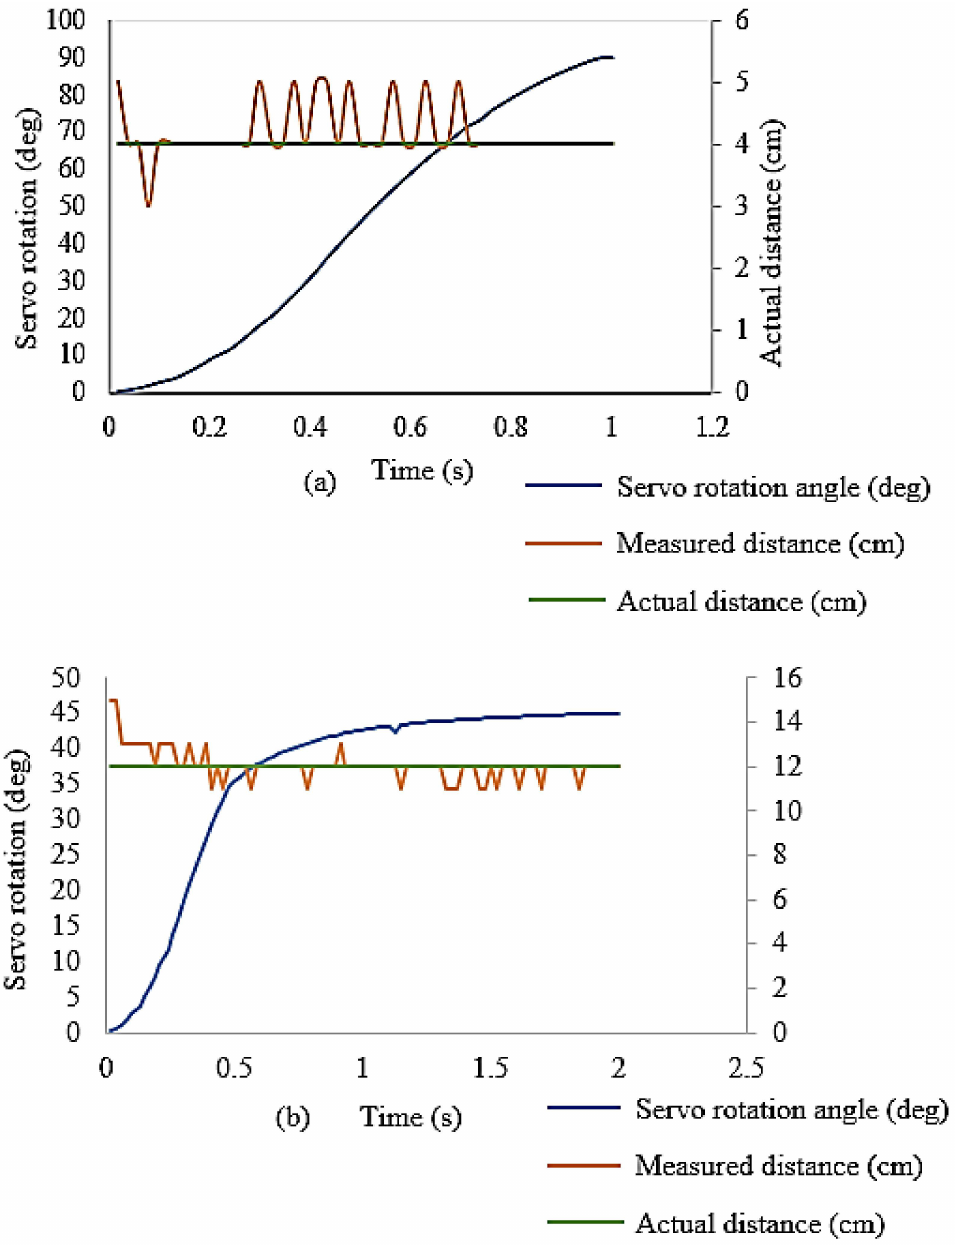
Figure 11. Ultrasonic sensors response and servo motor actuation ( a ) Sensor kept at 40 mm ( b ) Sensor kept at 120